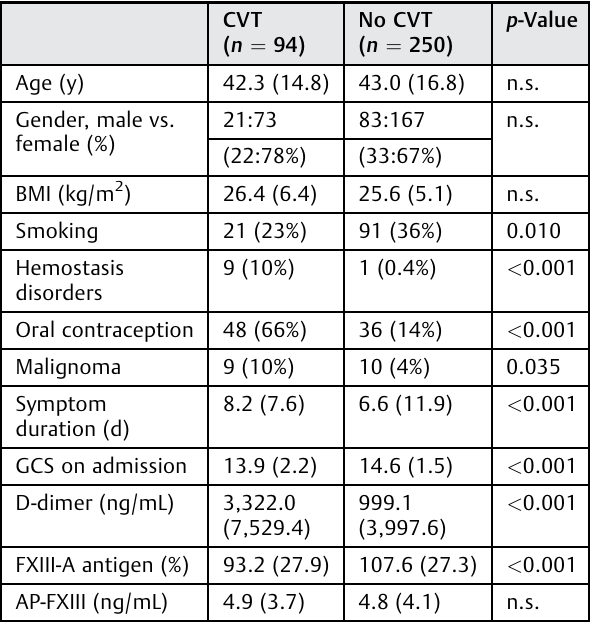
Table 1 Characteristics of CVT and non-CVT